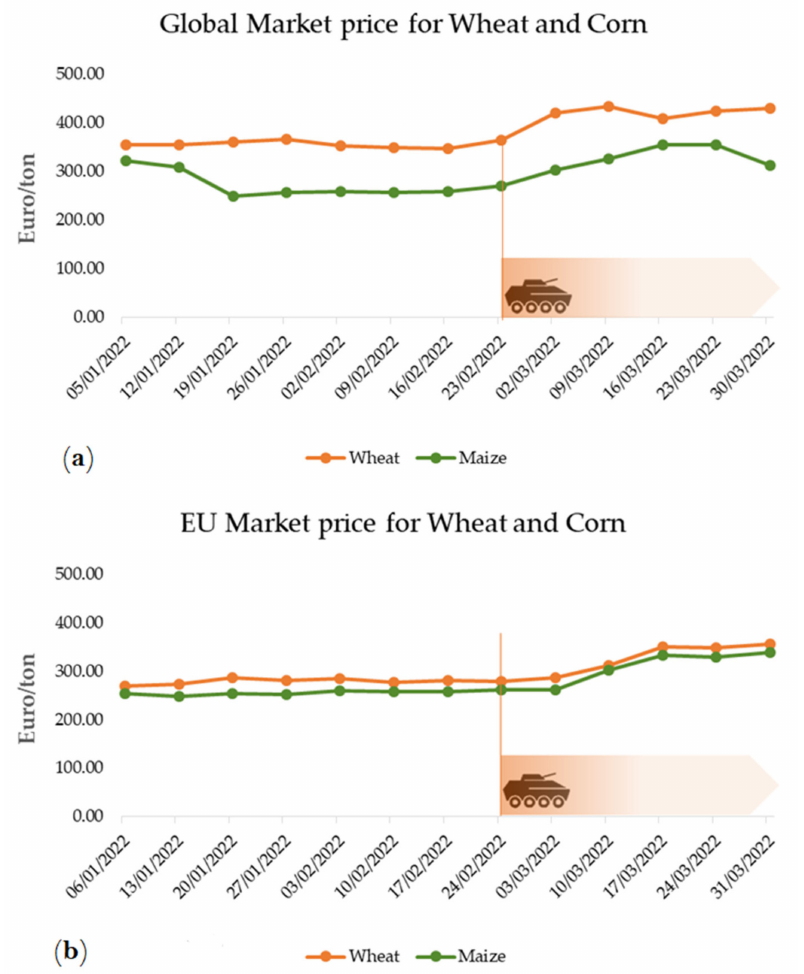
Figure 6. Average global ( a ) and European ( b ) prices for commercialization of wheat and maize during January-March 2022. Data adapted from the Cereal statistic webpage of the European Commission